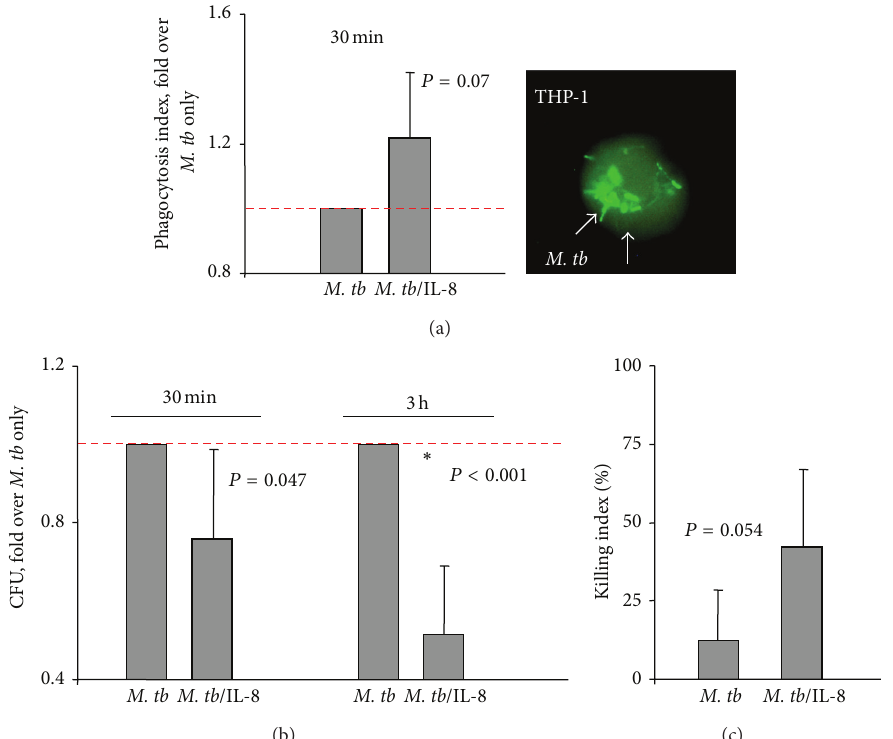
Figure 4: Effect of direct association of IL-8 with M. tb molecules on the ability of THP-1 cells to phagocytose and kill M. tb . (a) Phagocytosis of M. tb only ( M. tb ), or M. tb bound to IL-8 ( M. tb /IL-8) presented as a phagocytosis index/increase fold over M. tb only. Image of THP-1 cell phagocyting M. tb conjugated with FITC photographed under fluorescent microscope. (b) Phagocytosis and killing of M. tb only ( M. tb ), or M. tb associated with IL-8 ( M. tb /IL-8) calculated after 30min and 3 h of infection using colony forming units (CFU) method and presented as a CFU/fold over M. tb only. (c) Killing index ( % ) calculated for M. tb cytokine-free ( M. tb ) and M. tb associated with IL-8 ( M. tb /IL-8) according to the formula ([CFU at 30 min − CFU at 3 h] × 100/CFU at 30 min).